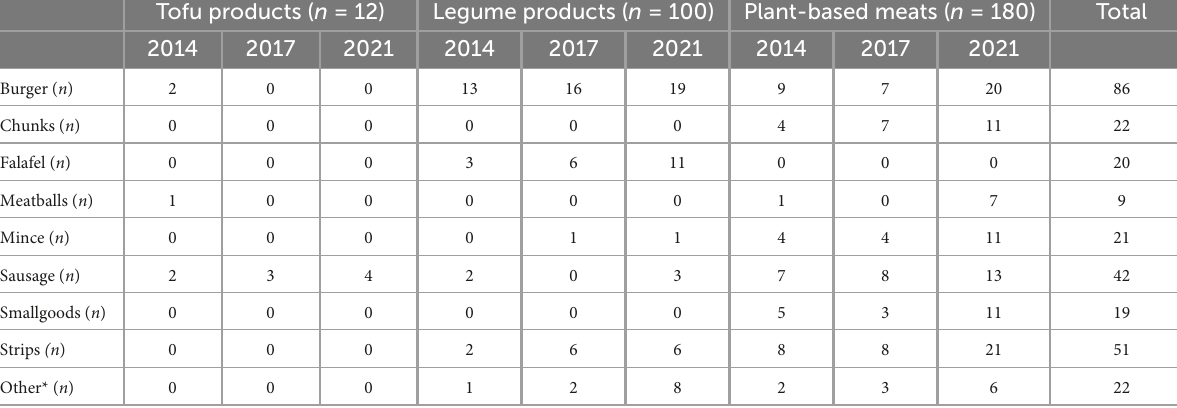
TABLE 4 Changes in product numbers and format of alternative protein products sold in 2014, 2017, and